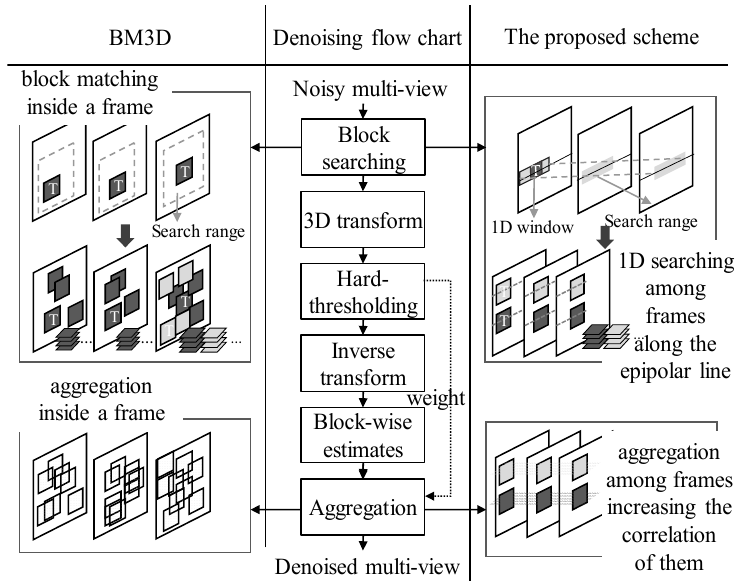
Figure 1. Flow chart of the proposed scheme.